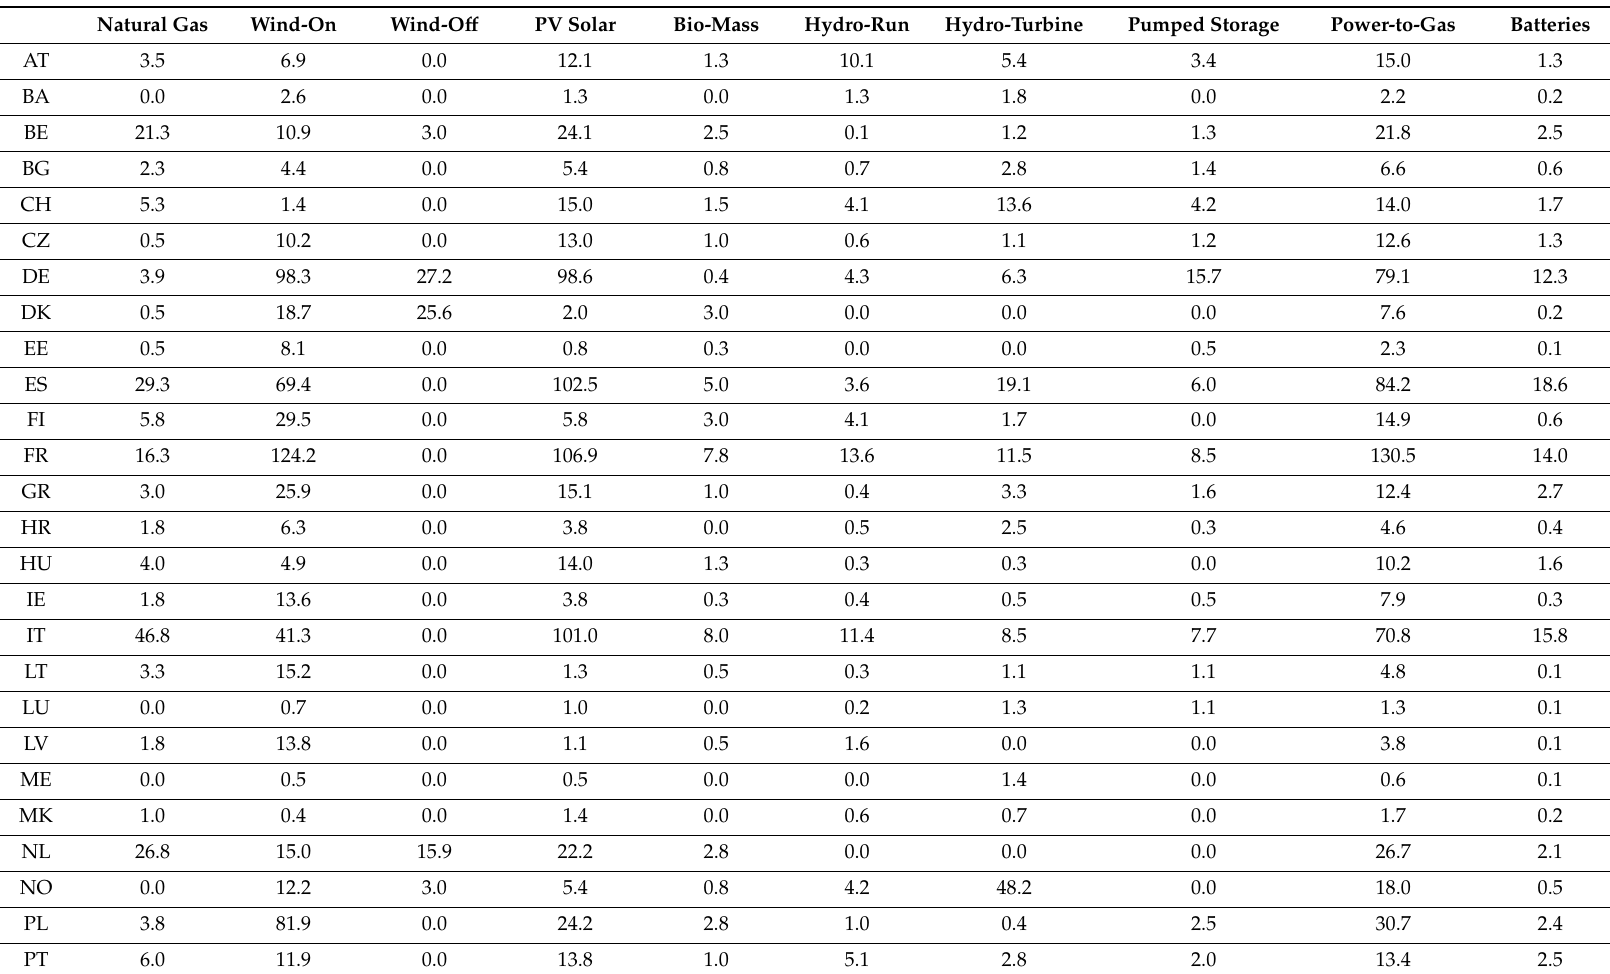
Table A4. Installed capacities in GW, scenario year 2050. Source: References [28,29] and own